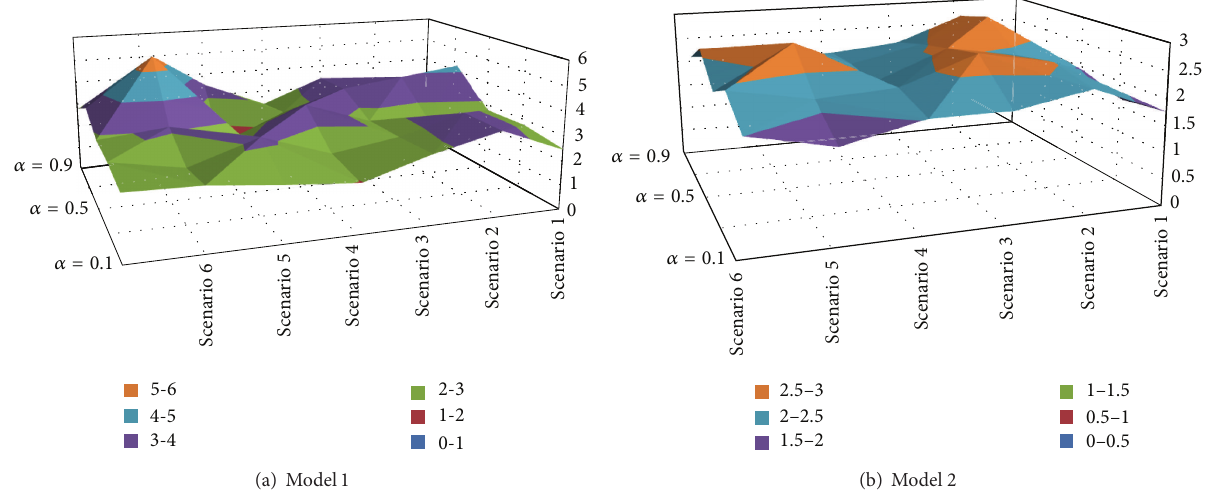
Figure 12: REP changes in different scenarios with respect to speed parameter. adj , ddm